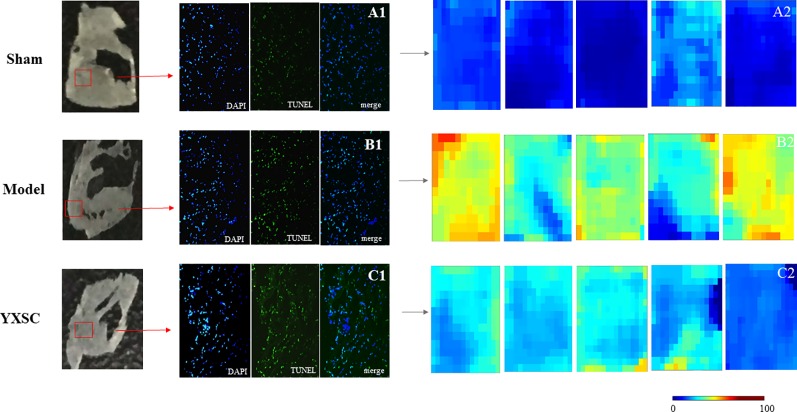
In situ MALDI-MS and the levels of all metabolites at the apoptotic section of the hearts from sham group, model group, and YXSC group. Microscope images for whole Tunel stained heart sections from sham group (A1), model group (B1), and YXSC group (C1) (40 X). Heat map describing the total ion intensity at the region of apoptosis on the heart section from sham group (A2), model group (B2), and YXSC group (C2).